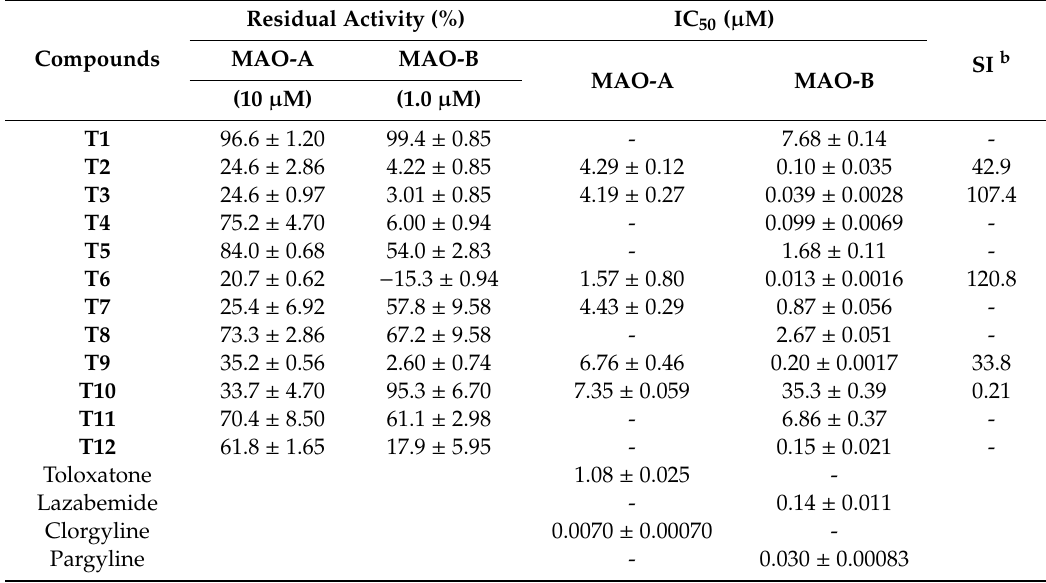
Table 2. Inhibitions of recombinant human MAO-A and MAO-B by T1 to T12 a .